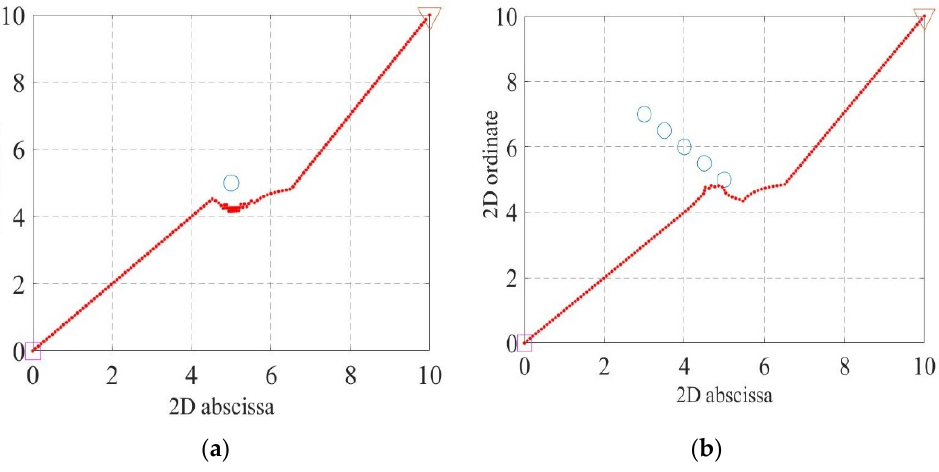
Figure 14. Simulation results under traditional artificial potential field: ( a ) Single obstacle; ( b ) Multiple obstacles.